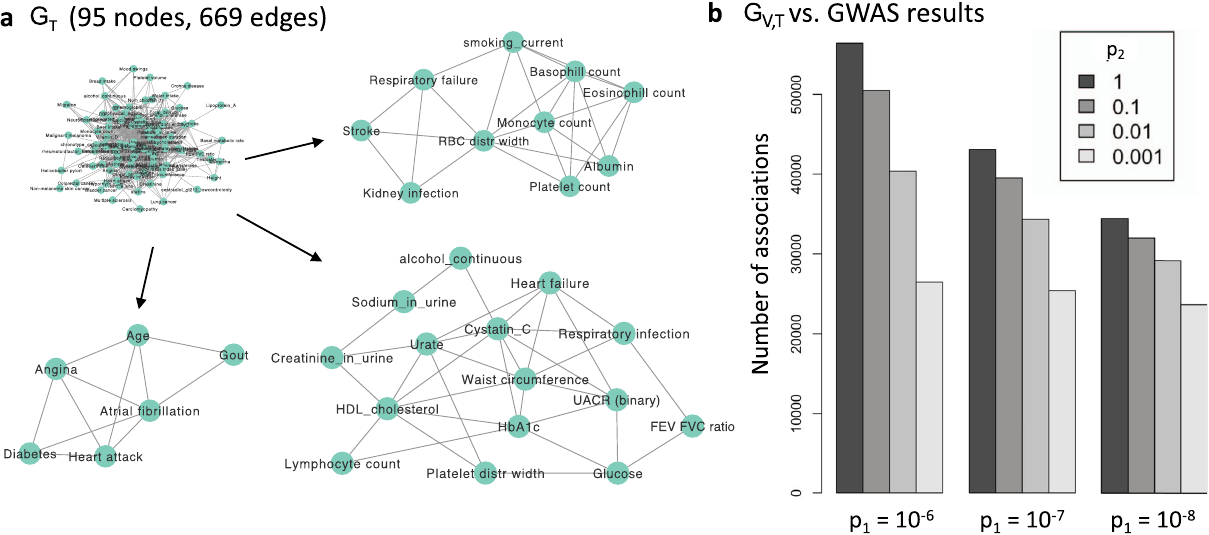
Fig. 4 Inferred skeletons that represent associations that are robust to conditioning. a The skeleton inferred among the phenotypes ( G T ). The edges represent phenotype pairs that remain associated at p 1 < 1 × 10 − 7 when conditioned on other phenotypes. In this computation for a pair of variables X and Y , we tested the association between X and Y conditioning on all other phenotypes or all other phenotype pairs. Arrows point out to clusters detected with MCODE. b The effect of conditional independence fi ltering on genome-wide association analysis (GWAS) results. Here we show the effect of removing variant – phenotype pairs (detected in a standard GWAS) for which there exists another phenotype whom conditioning upon renders the association insigni fi cant (> p 2